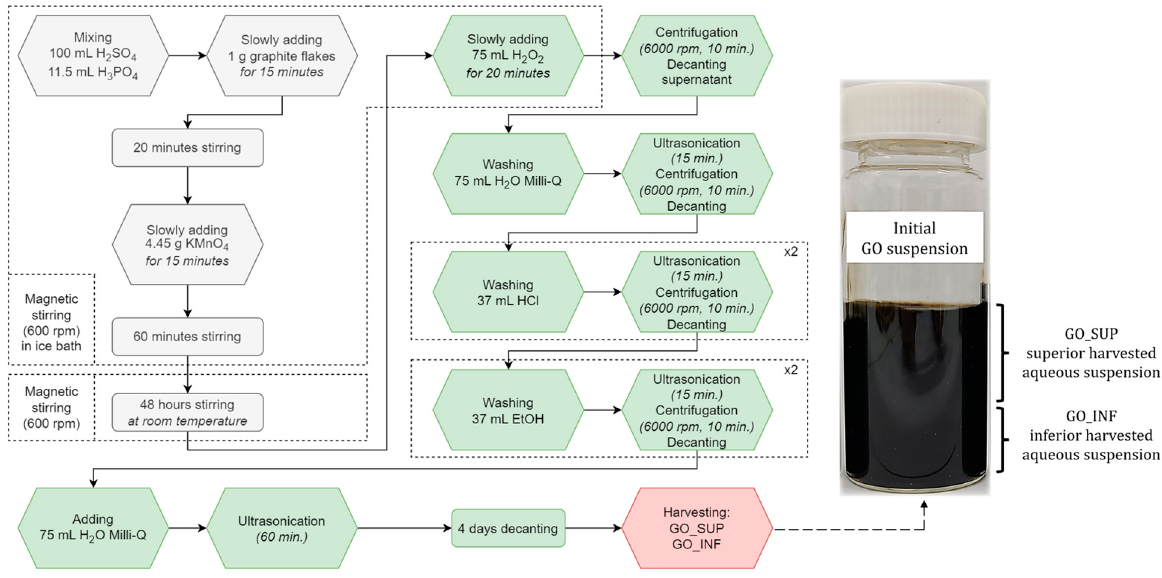
Figure 1. Schematic representation of the synthesis process of the obtained superior (GO_SUP) and inferior (GO_INF) GO aqueous suspensions.